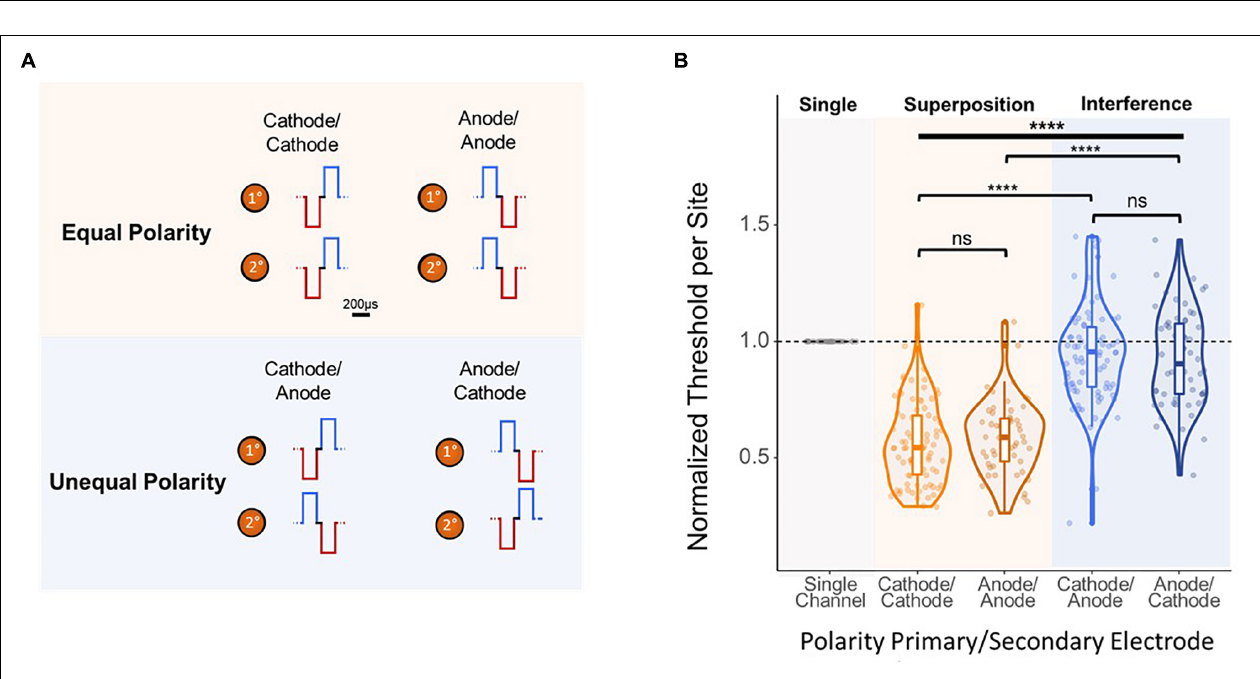
FIGURE 6 | Effect of polarity of 2-site simultaneous stimulation on per-site threshold charges. (A) Layout of stimulated channels and stimulation paradigm for equal and opposite polarity experiments. Primary electrode-site located 1,100 µ m from the cortical surface; secondary electrode-site located 100 µ m deeper than primary site. For equal polarity trials, cathode- or anode-leading waveforms were used in both electrode sites. For opposite polarity trials, each channel used a waveform with a different leading polarity (primary channel cathode-leading with secondary channel anode-leading, and vice-versa). (B) Effect of 2-site simultaneous stimulation waveform polarity on per-site threshold charge levels (threshold charges normalized to average single-site primary electrode site thresholds from stimulation with corresponding leading phase polarity; one-way ANOVA (bold line) and t -test (brackets) ****p ≤ 0.0001.